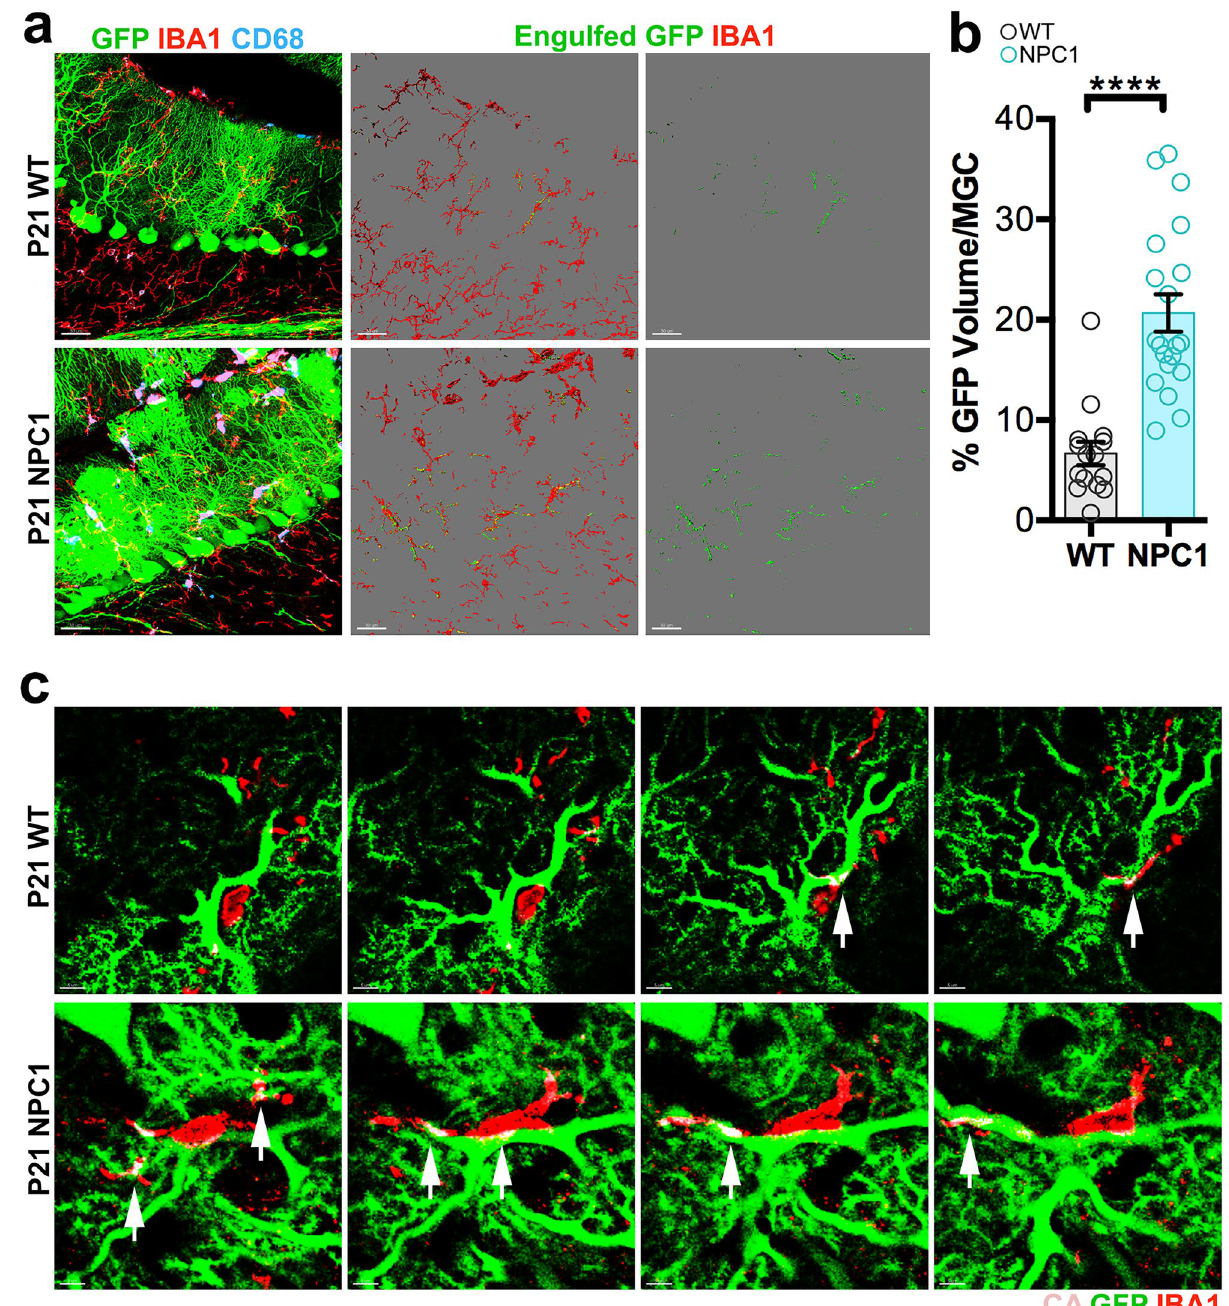
Figure 2. Increased contacts and engulfment of PC dendritic GFP and VGLUT1 + presynaptic inputs by microglia in P21 Npc1 nmf164 mice. ( a ) Confocal images and 3D surface renderings showing segregated IBA1 + microglial cells from P21 WT and Npc1 nmf164 mice contacting or engulfing GFP + PC dendrites. The third column is showing 3D surface renderings of the contacted or engulfed GFP from PC dendrites. ( b ) Quantitative analysis of the total volume of contacted or engulfed GFP + dendrites in P21 IBA1 + microglia. ( c ) High magnified serial sections from the confocal Z stack in ( a ) showing GFP + dendrites contacted or engulfed (CA = contacted area, white arrows) by IBA1 + microglia at P21. Data are presented as mean ± SEM, WT n = 4–5 cells/mouse from 4 mice, Npc1 nmf164 n = 4–5 cells from 4 mice. ****P < 0.0001. Scale bar: ( a ) 30 μm, ( c ) 5